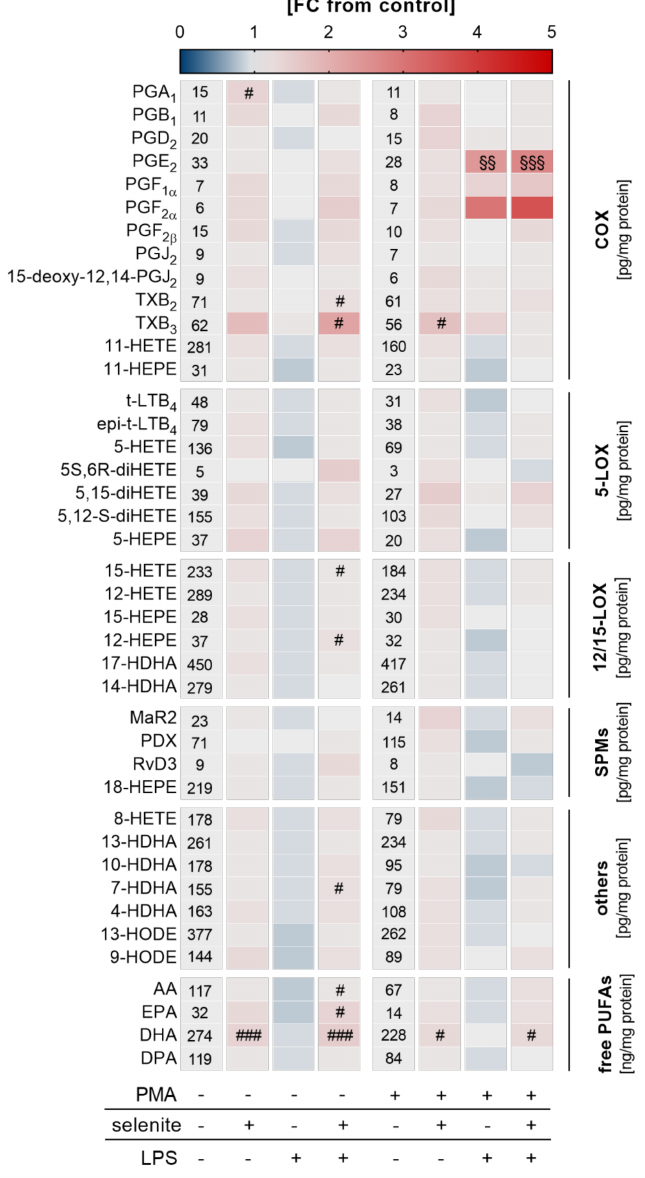
Figure 4. Effect of Se, PMA-induced differentiation, and LPS on lipid mediator (LM) profiles. THP-1 cells were pre-treated with or without 50 nM sodium selenite (selenite) for 72 h and differentiated into macrophages by treatment with 25 nM PMA in co-treatment with or without 50 nM sodium selenite (selenite) for 48 h and with or without 1 µ g/mL lipopolysaccharide (LPS) for an additional 24 h. LM profiles of the supernatant were analyzed by UPLC-MS/MS. The heatmap organizes LM according to key biosynthetic enzymes (n = 4). The values in the columns give the concentrations of LMs in pg/mg protein (COX, 5-LOX, 12/15-LOX, SPMs, others) or ng/mg protein (free PUFAs). The color scale indicates the mean difference as fold change (FC) of control cells vs. LPS and/or selenite-treated cells (FC = 1). Two-way ANOVA with Bonferroni ´ s post-test. Significant outliers were determined